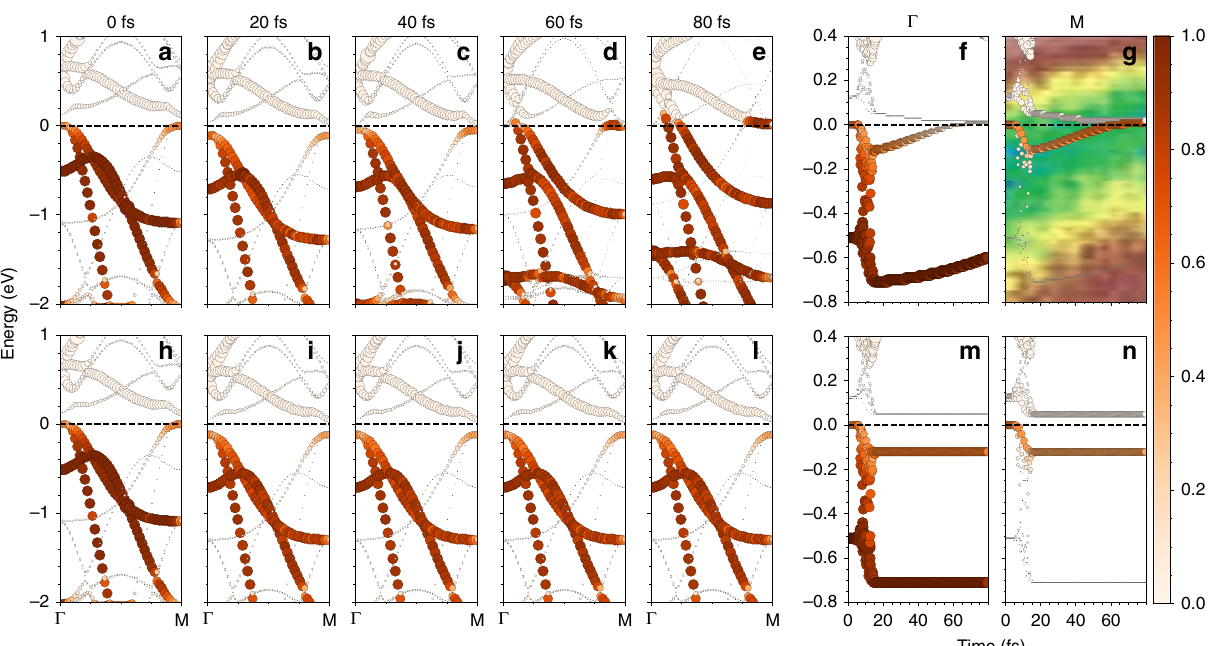
Fig. 5 Time dependent band structure . Snapshots of TD-EBS for ( a – e ) the PLD dynamics, and ( h – l ) the quenched case. EBS at Γ and M point as a function of time for ( f – g ) PLD dynamics and ( m - n ) the quenched case. The color bar denotes the carrier population. The squares in ( g ) mark the experimental tr- ARPES data, reproduced from ref. 66